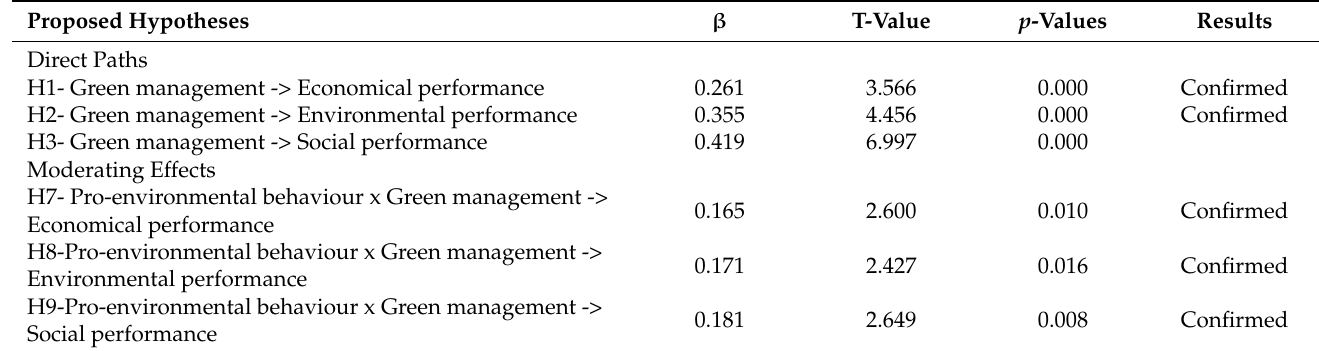
Table 5. The findings of the inner